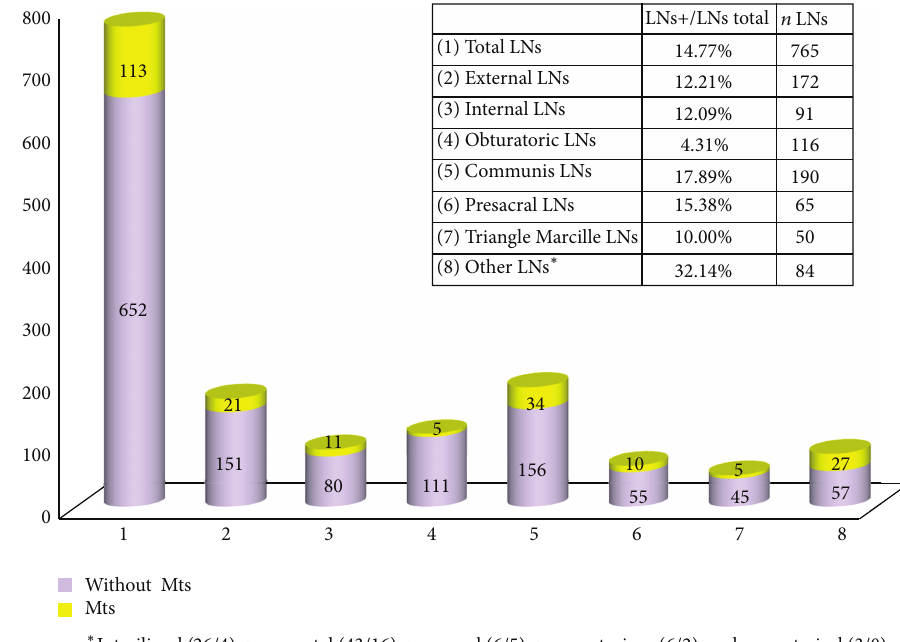
was in the obturator LNs (4.3%). Although a relatively large number of nodes (116) were removed from this area—which is standard in LND in PCa—the percentage of LN metastases was very low. More LNs were only removed in the A. iliaca communis area (190) and the A. iliaca externa (172), however with a high percentage of positive LNs (17.9% and 12.2%, resp., as mentioned above).